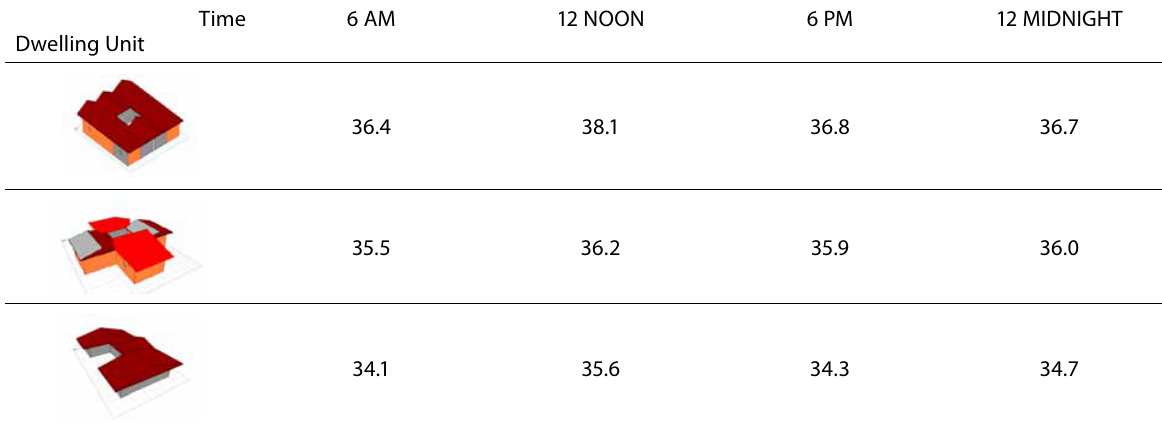
Table 5. Temperature measurements inside different types of courtyard dwelling units selected for detailed study at different times of the day and night on 29th May in hottest week of the year Time 6 Dwelling unit